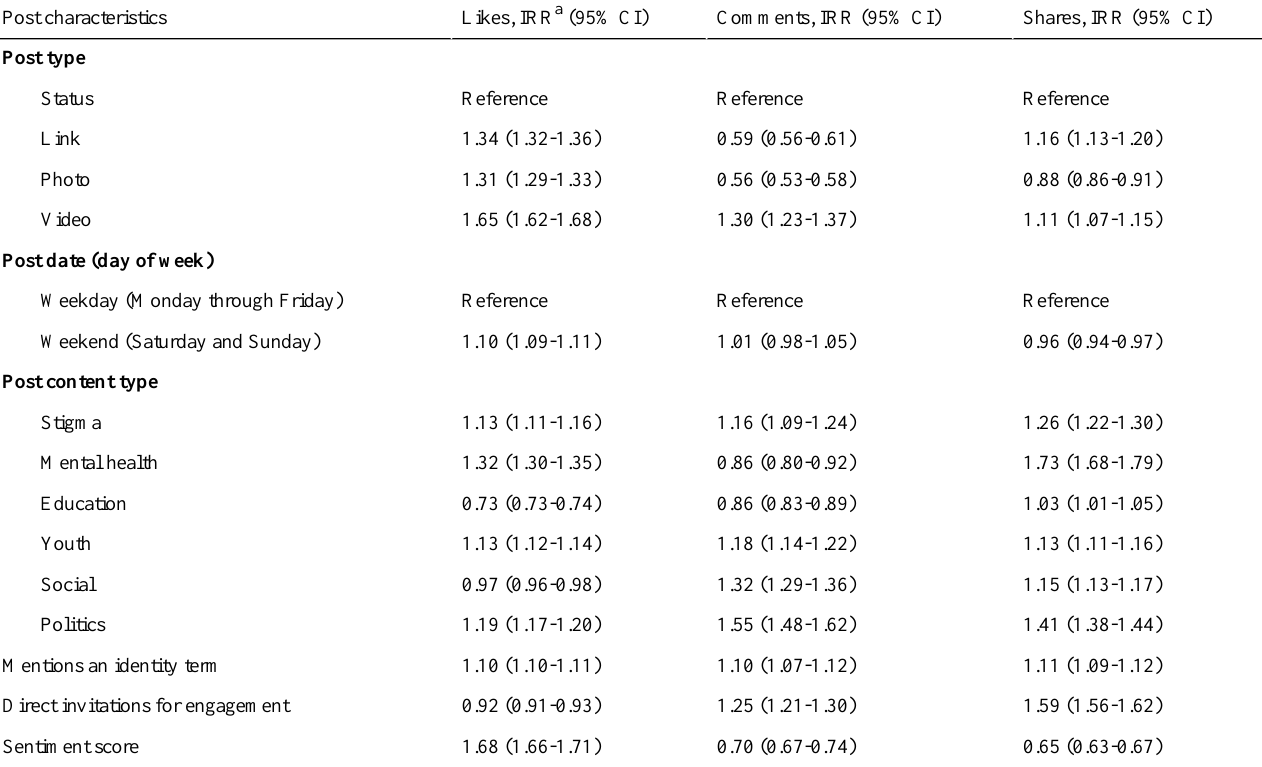
Table 4. Associations of post characteristics with specific types of user engagement with Facebook posts (likes, comments, and shares) by lesbian, gay, bisexual, transgender, and queer community centers in the United States,